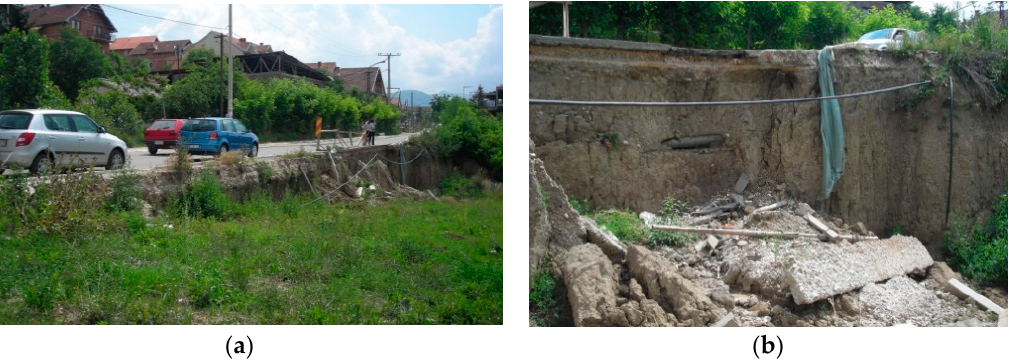
Figure 5. Slipway on the part of the regional road II of line R234, Novi Pazar-Rajeti ć e ( a ) right view; ( b ) central view